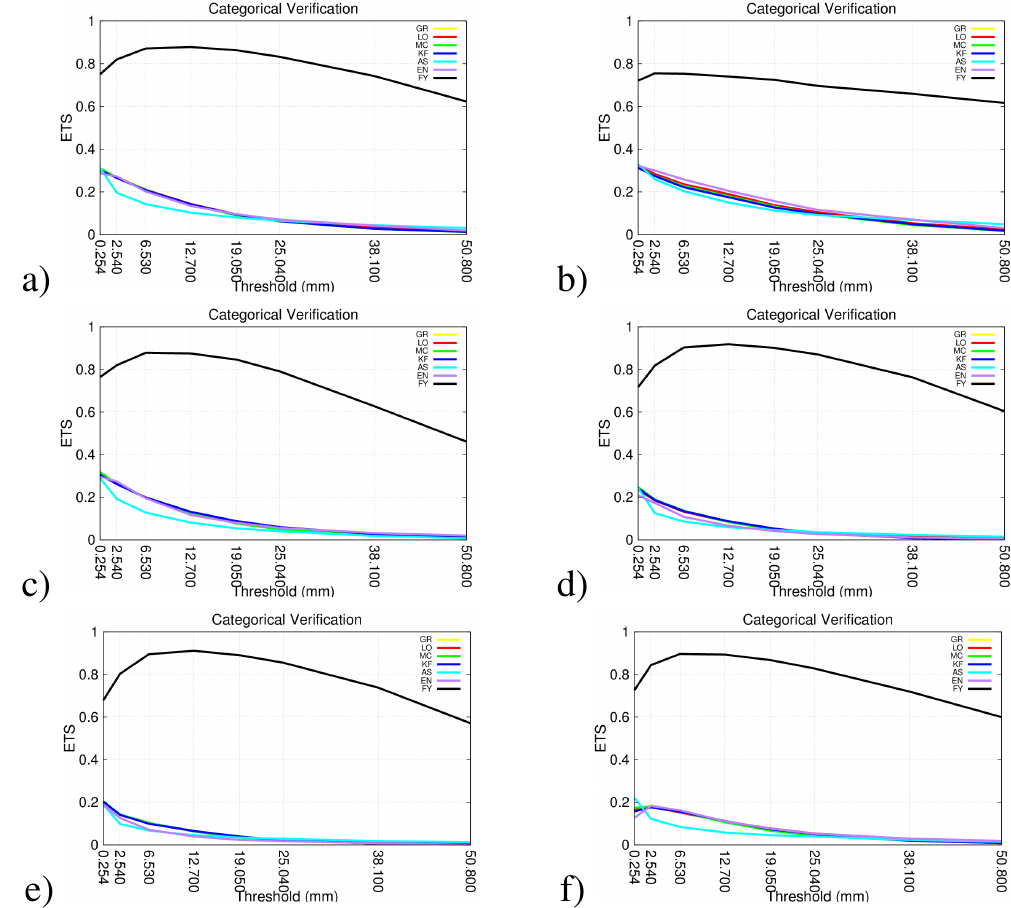
Fig. 5. Bias score vs precipitation thresholds (0.254 mm, Fig. 6. ETS score vs precipitation thresholds (legends are the same 2.54 mm, 6.53 mm, 12.7 mm, 19.05 mm, 25.4 mm, 38.1 mm, 50.8 mm) for a) as Figure South America, b) area 2, c) area 3, d) area 4, e) area 5, f) area 6.